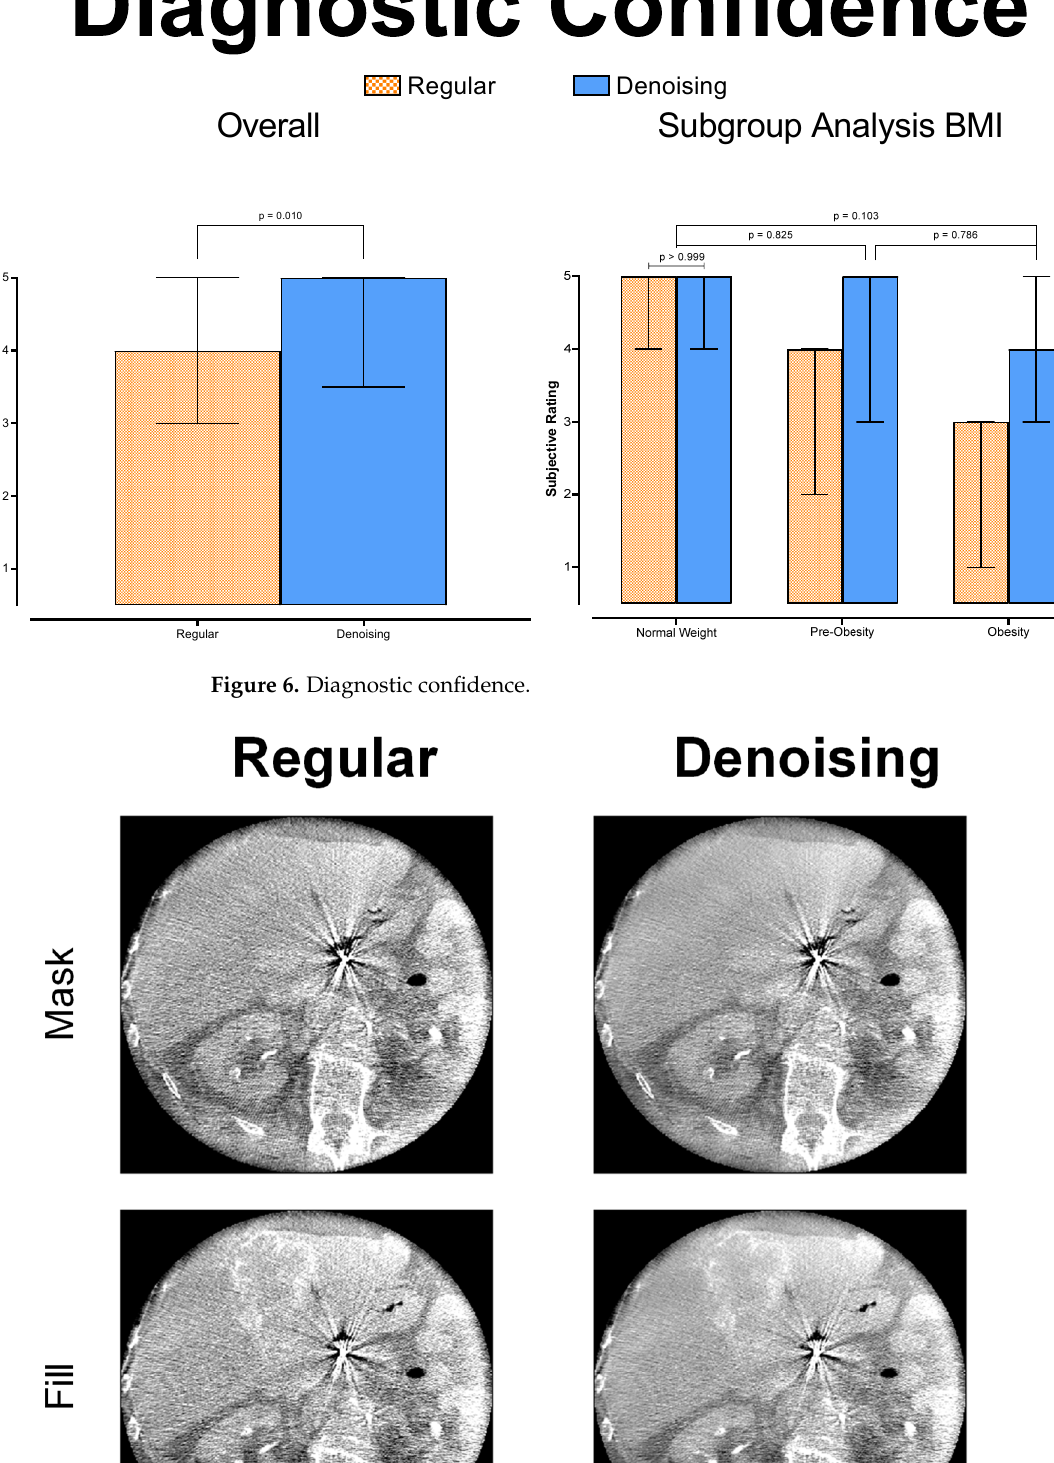
Figure 7. Example images of a 68-year-old adipose male patient (BMI = 30) undergoing SIRT for hepatic uveal melanoma metastases.